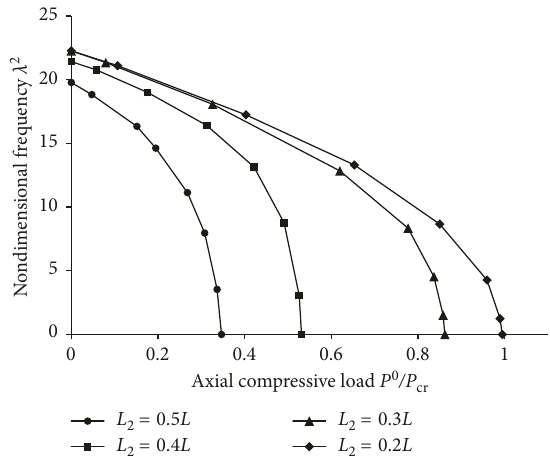
Figure 4: Fundamental natural frequency λ 2 of homogeneous beam with clamped-clamped boundary condition, M zz / M b and central delamination located in midplane H 2 / H normalized axial force in “free mode” model for different values of L 2 / L .